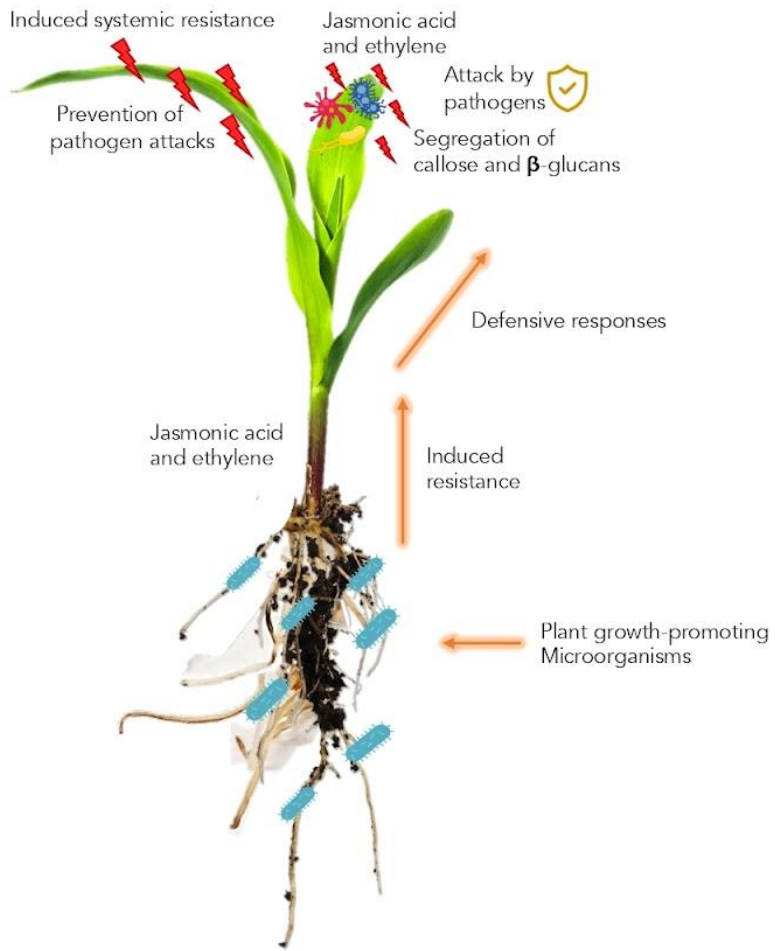
Figure 3. Priming generated by beneficial microorganisms in the rhizosphere, causing activation of resistance which may initially be local, but eventually becomes systemic by jasmonic acid and eth- ylene.